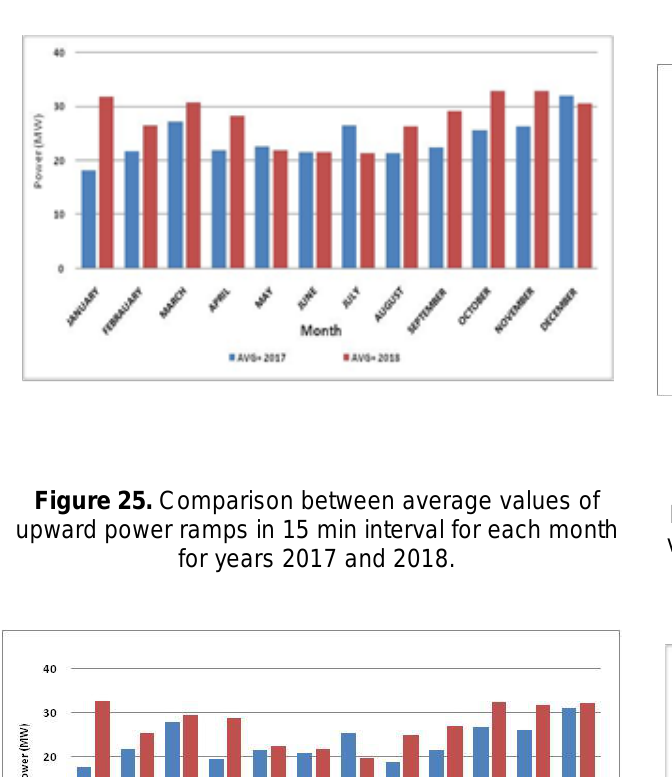
Figure 24. Comparison between numbers of downward power ramps in 15 min interval for each month for the years 2017 and 2018.